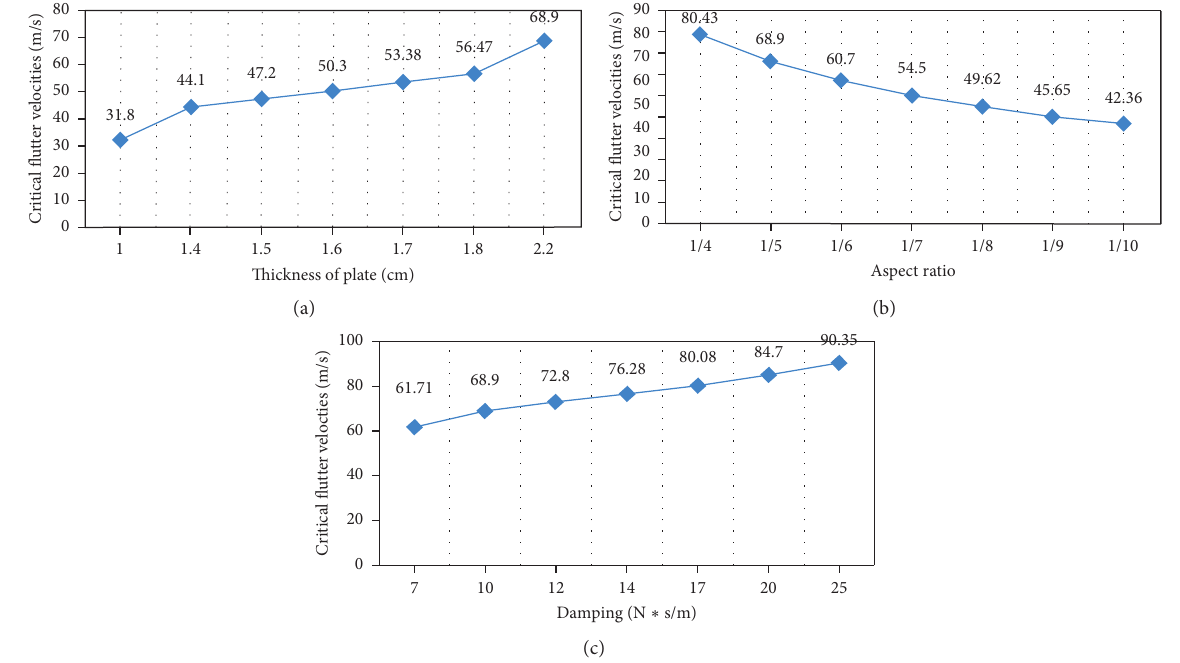
Figure 19: Influences of different factors on critical flutter velocities: (a) plate thickness; (b) aspect ratio; (c)